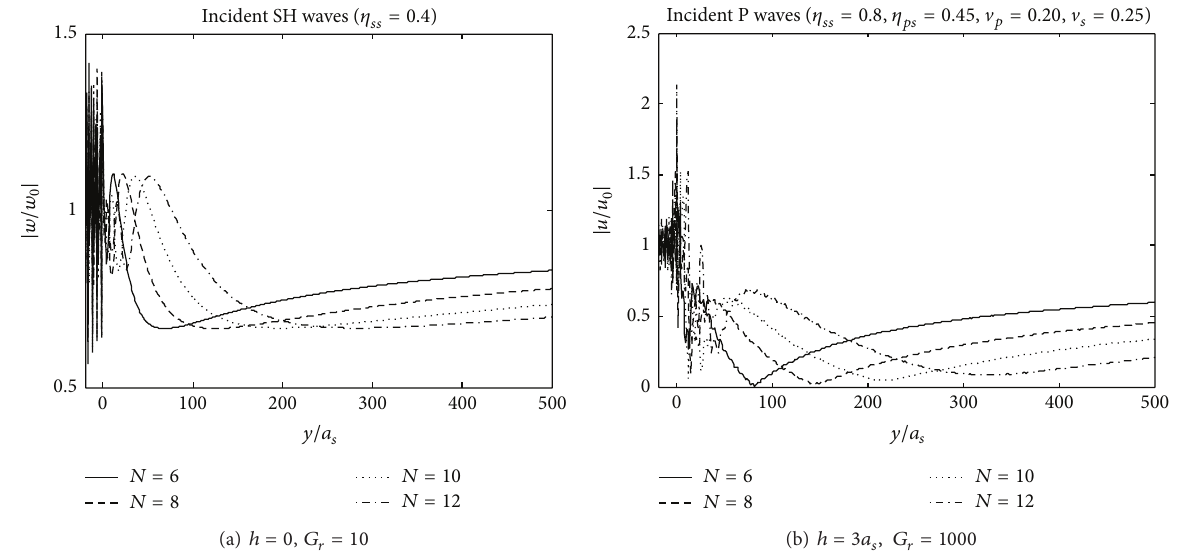
Figure 10: Normalized displacement amplitudes curves along midline behind the isolation system under different numbers of tubular piles ( 𝑏 𝑠 = 0.9𝑎 𝑠 , 𝑠 𝑝 = 3.0𝑎 𝑠 , 𝑚 = 4 , 𝑁 = 8 ).